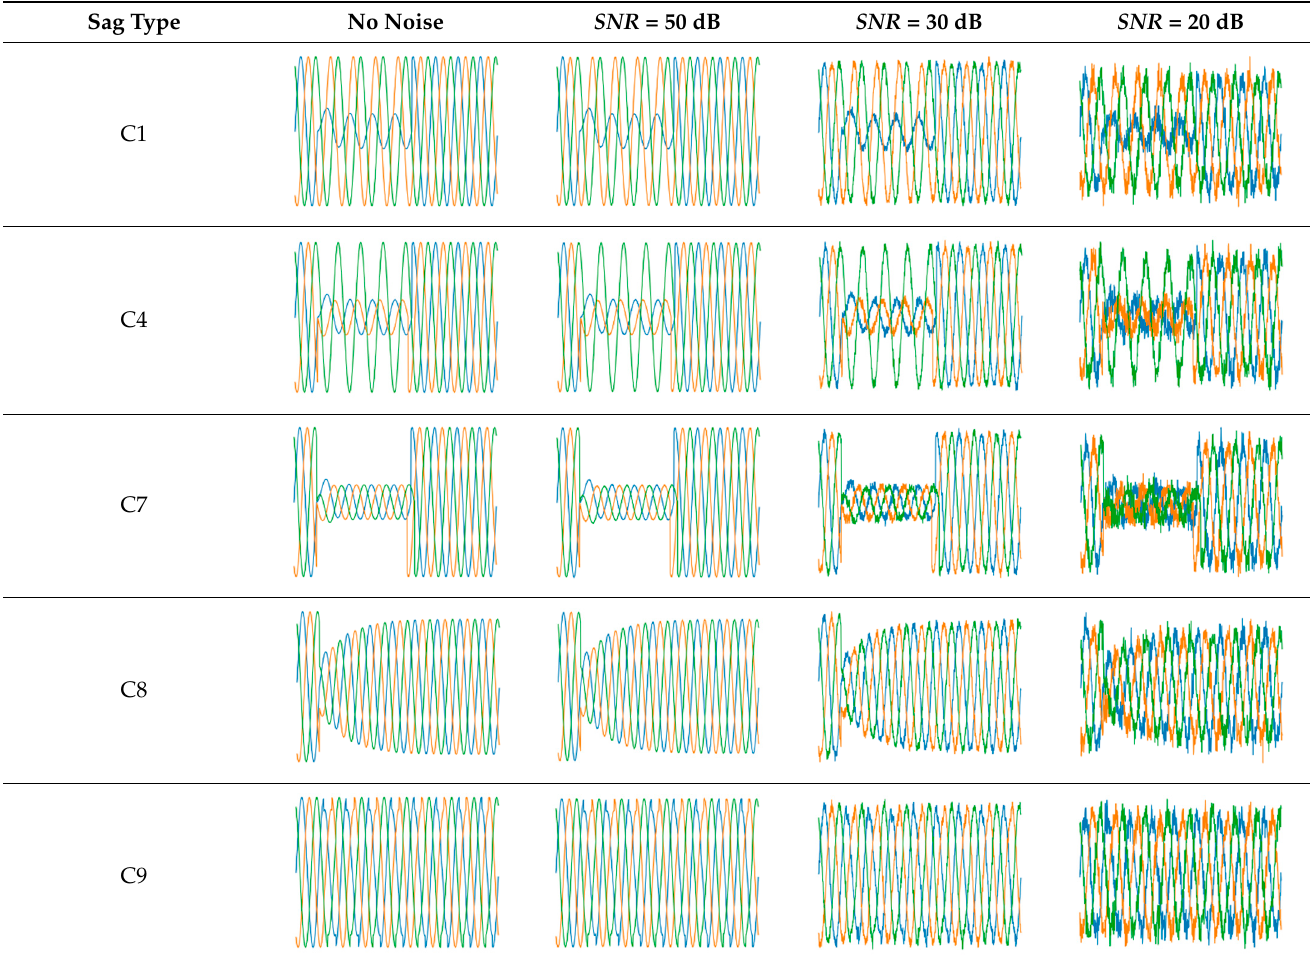
Table 1. The waveforms of different voltage sag types under different noises.